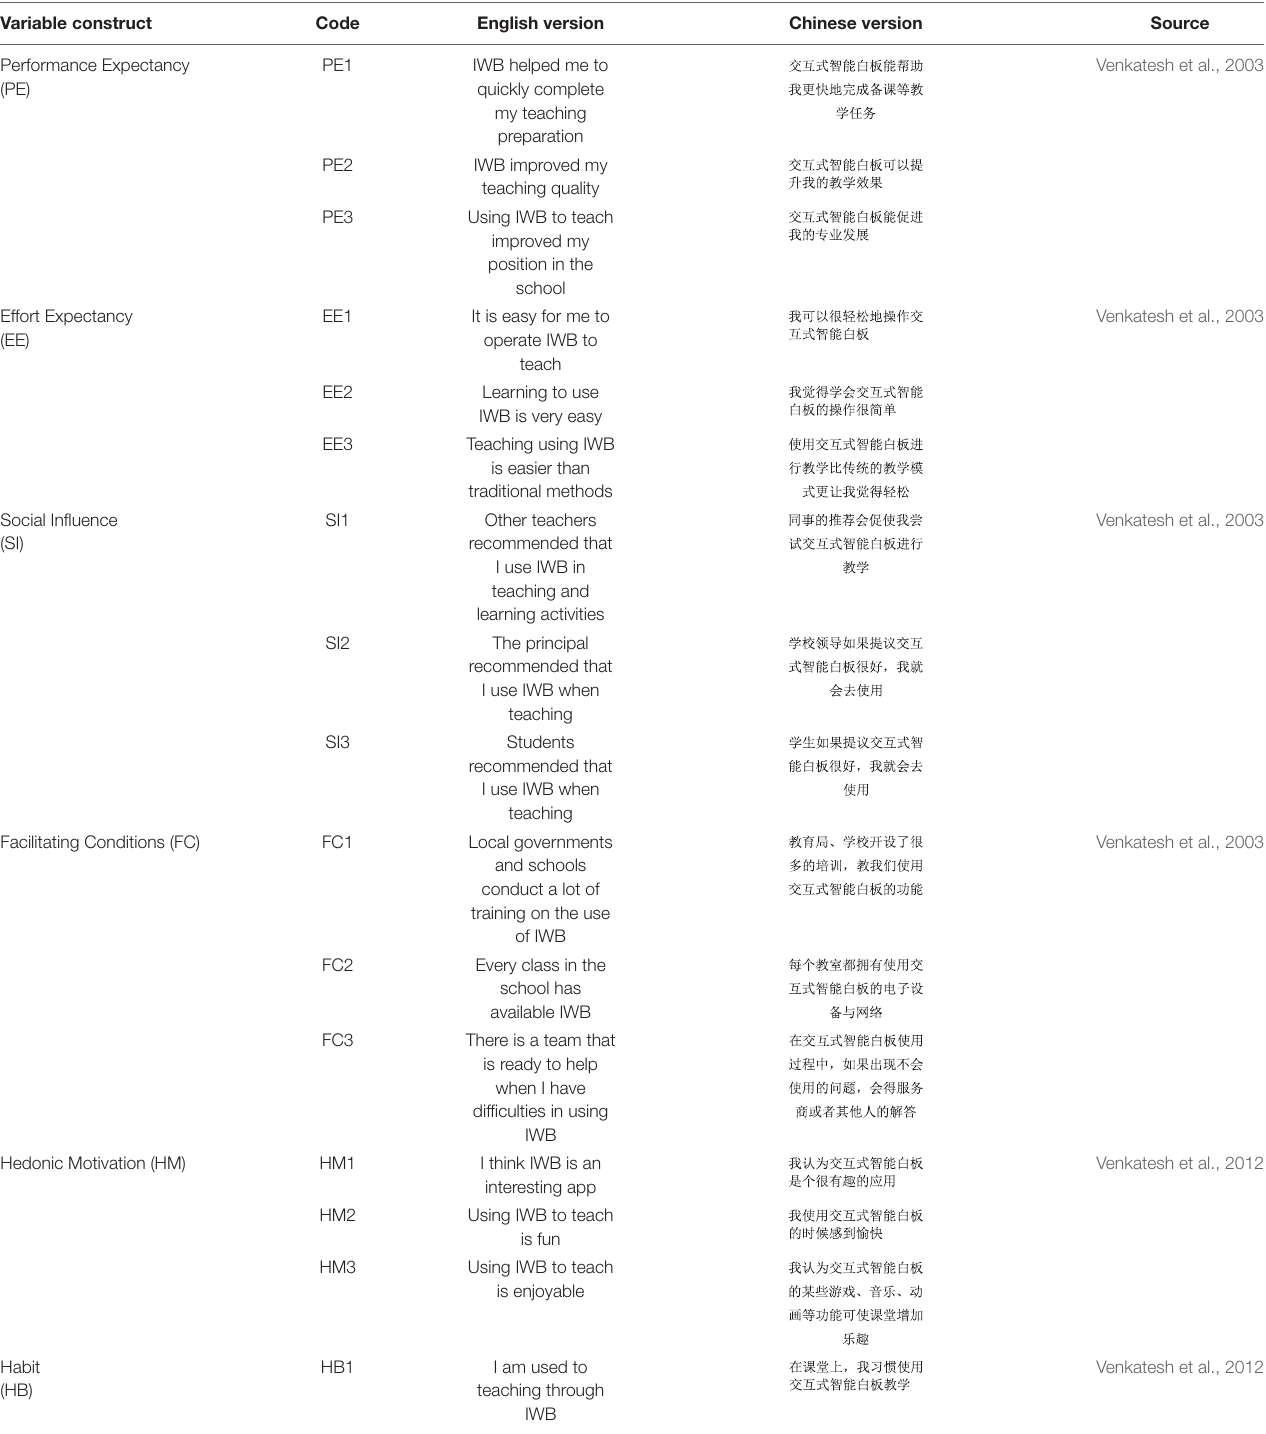
TABLE A1 | Detailed questionnaire